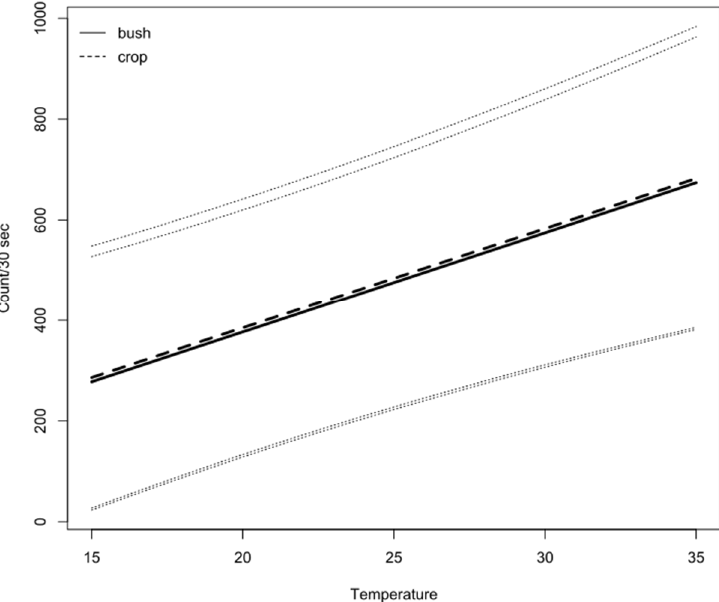
Figure 7. Estimated mean honey bee counts per 30 s with 95% confidence intervals, based on counts recorded at 1500 h, analyzed against temperature (°C) for hives that were monitored during the summer following pollination services of almond (crop) versus placement in Mallee bushland (bush). Table 3. Estimated regression parameters, standard errors, t-values, and p -values for the Gaussian generalized additive mixed model conducted to compare bee activity for hives monitored during summer (post-pollination) for the cohort of hives placed previously in almond orchard versus in bushland settings. Smoothing terms included climate variables temperature and windspeed for the site factor.